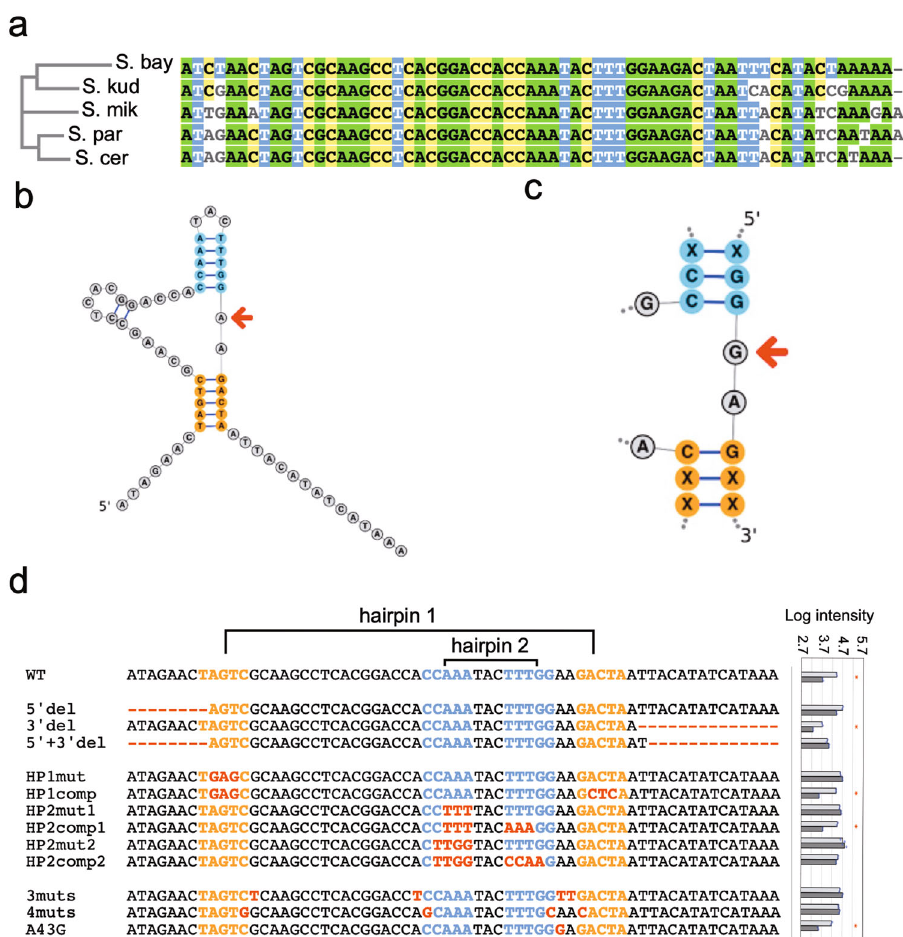
Fig. 4 RPL1B autoregulation. a Alignment of the 5 ′ UTR sequence of RPL1B across different species of saccharomyces shows a high level of conservation. b The predicted structure of the RPL1B 5 ′ UTR with hairpin stem 1 (HP1) in orange and hairpin stem 2 (HP2) in blue. The red arrow indicates A at position 43 which differs from the G nucleotide seen in the consensus motif bound by Rpl1 in other species. c The common sequence and structure motif bound by Rpl1 in other species. The red arrow indicates the G nucleotide that is changed to A in RPL1B ’ s 5 ′ UTR sequence. d Variant sequences of the RPL1B 5 ′ UTR that were used to probe the sequence and structure requirements for autoregulation by Rpl1. Variants included deletions from the 5 ′ and 3 ′ ends, mutations to disrupt the hairpin stem structures, as well as compensating mutations to restore them, and mutations affecting the core GGAAG of the motif. The log GFP expression for uninduced (light bar) and induced (dark bar) cells are shown to the right for each sequence. * indicates UTR sequences with great than 3-fold repression.